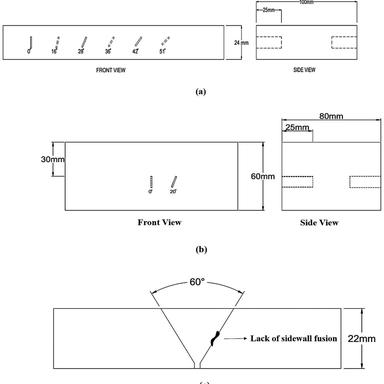
(a) 24 mm thick stainless steel plate with inclined slots (b) 60 mm thick stainless steel plate with inclined slots and (c) 22 mm thick carbon steel weld joint with lack of sidewall fusion.